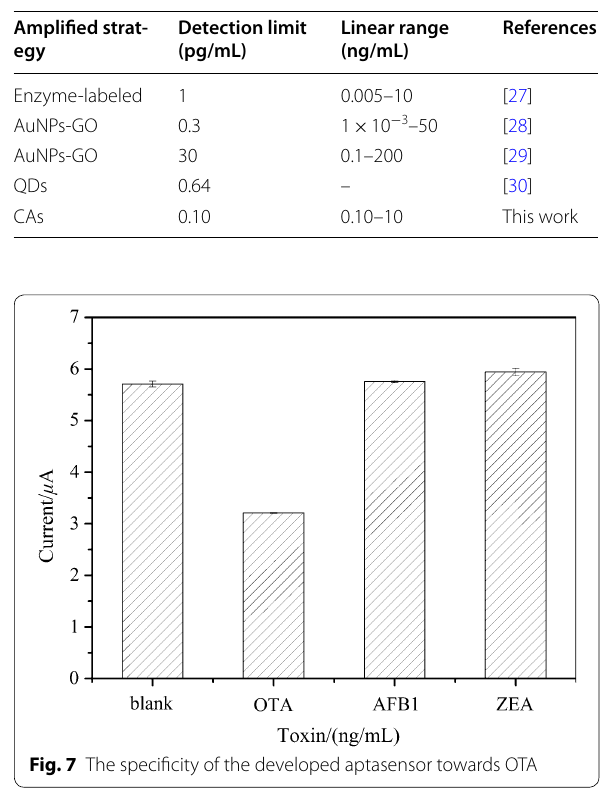
Table 1 Comparison with other reported aptasensors for OTA detection Amplified strat‑ egy